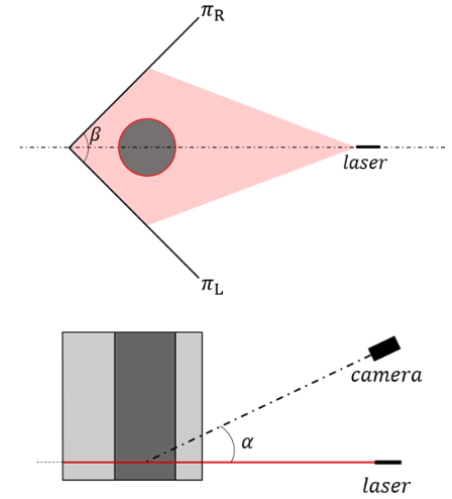
Figure 3: Schematic top and lateral view of the proposed LTS for 360° acquisition in one image.